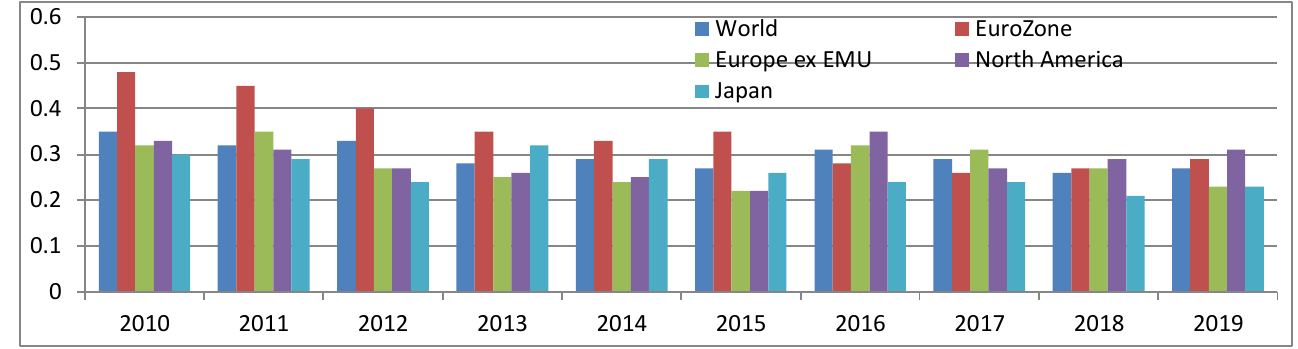
Figure 2: Region-wise dynamics of the average absolute concerning carbon risk Based on the dynamic common factor model, absolute versus relative carbon risk is measured in this research. The model is estimated by the Kalman filter. According to the graphical presentation, the relative carbon risk in North America is in a higher trend. Then appears chronologically portraying low carbon risk concerning countries portfolio are Japan, Europe and Eurozone respectively. The average absolute carbon risk concerning countries according to descending series are as follows: Eurozone, Europe, North America, Japan. According to the global region perspective, the absolute carbon risk is higher than the relative carbon